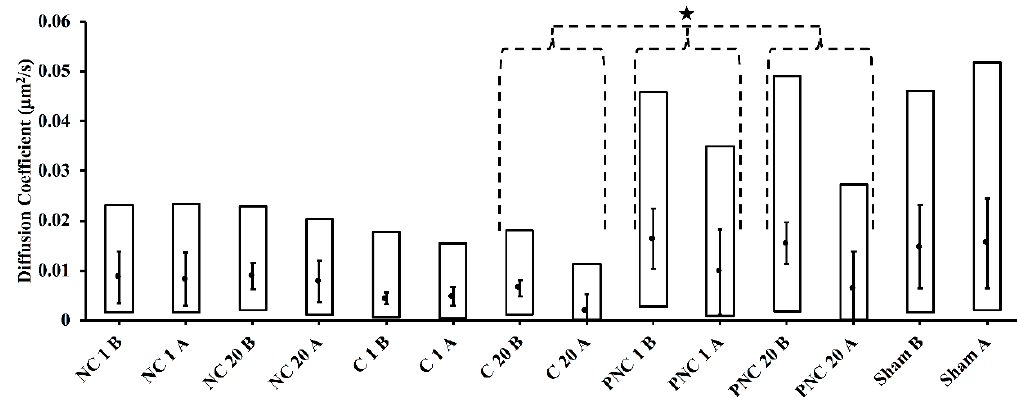
Figure 5. Diffusion coefficients for each condition tested are shown before and after exposure in box plots. The upper limit of the box represents the third quartile, while the bottom limit is the first quartile. The median is given as the middle dot. The star shape ( (cid:70) ) denotes a statistically significant difference according to the K-S test at alpha = 0.01 compared to pre-exposure. Error bars represent one standard deviation from the cell-to-cell mean value.